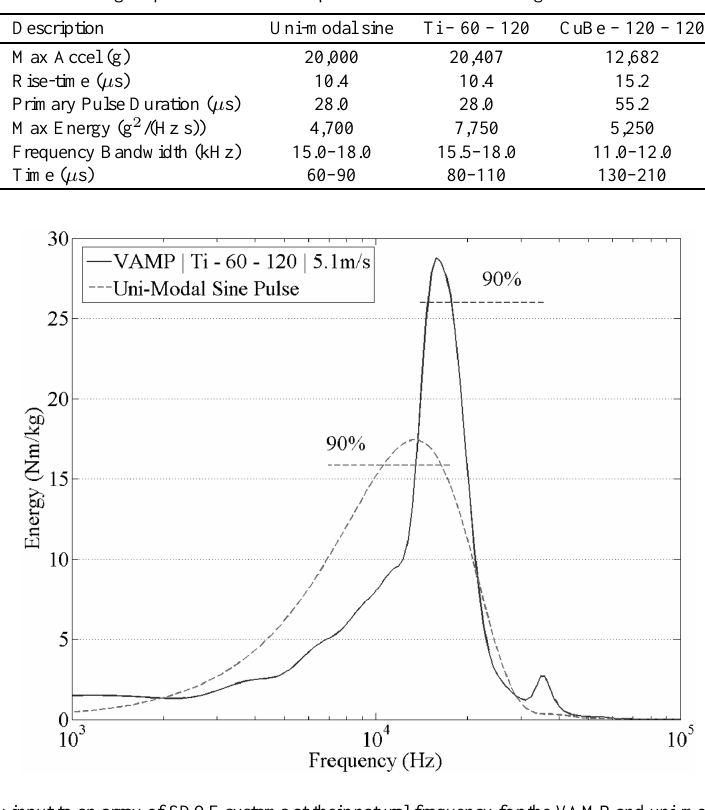
Fig. 13. Maximum energy input to an array of SDOF systems at their natural frequency for the VAMP and uni-modal sine acceleration